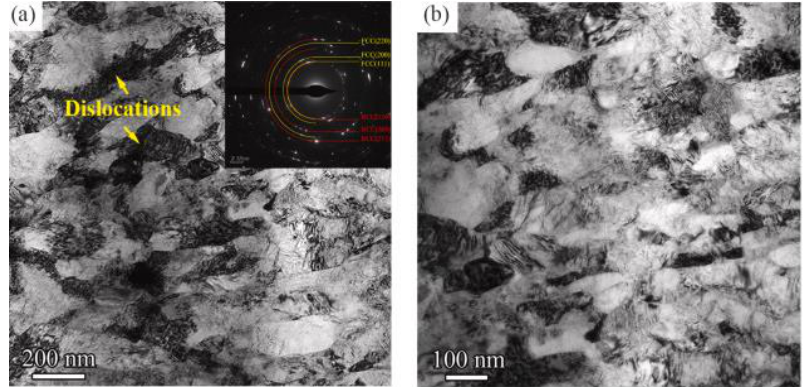
Figure 5. TEM of USSR’ed specimen : ( a ) low magnification image and SAED pattern, ( b ) high magnification image. Reprinted with permission from ref. [53]. Copyright 2021 Elsevier.